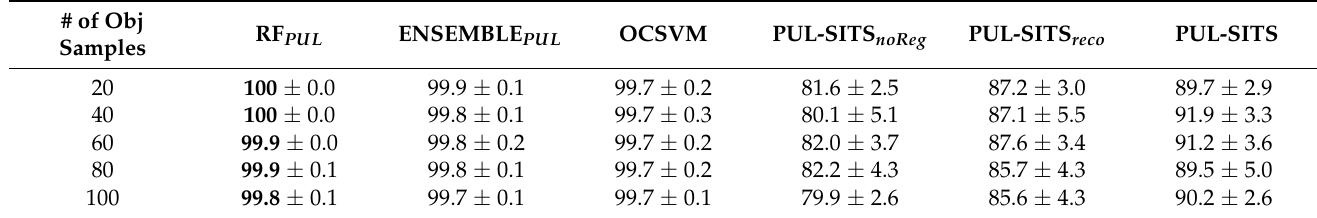
Table 11. Performances in terms of the Sensitivity of the different competing strategies when the land cover class of interest (the positive class) is Forest .